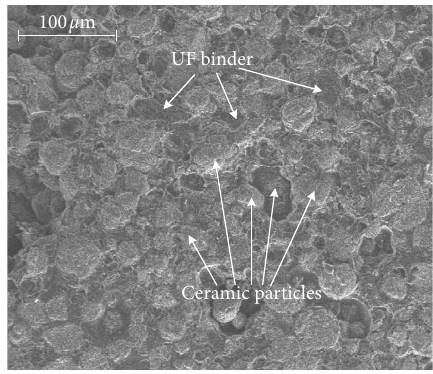
Figure 11: SEM image of the printed green specimens’ microstructures cured by UF